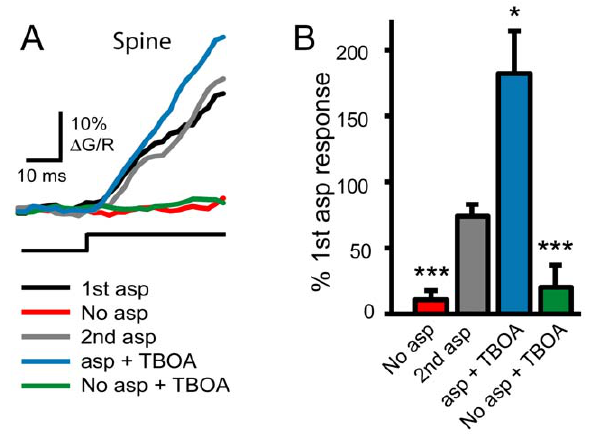
Figure 3. Transporter blockade does not reveal an ambient glutamate concentration gradient between extracellular com- partments. A. Average Ca 2 + increase in a spine during a 40 ms voltage step, with iontophoresis of L-aspartate (black), without iontophoresis (red), a second L-aspartate application (gray), L-aspartate in the presence of 100 m M TBOA (blue), and TBOA alone (green). B. Comparison of spine Ca 2 + transients in each condition, normalized to the first response to L-aspartate iontophoresis (n=5). Error bars indicate SEM. Significance determined by Friedman ANOVA with Conover posthoc test: *p , 0.05; **p , 0.01; ***p ,